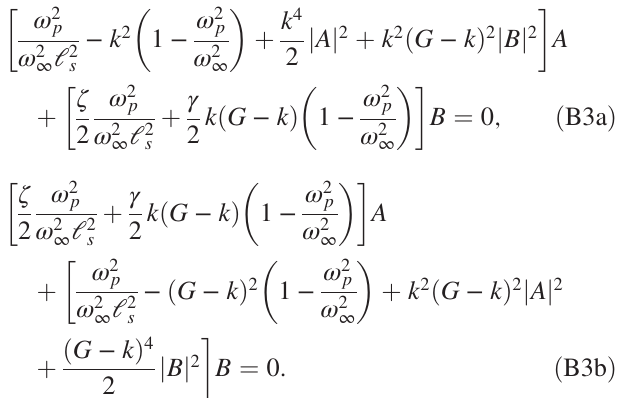
Coulomb screening length l